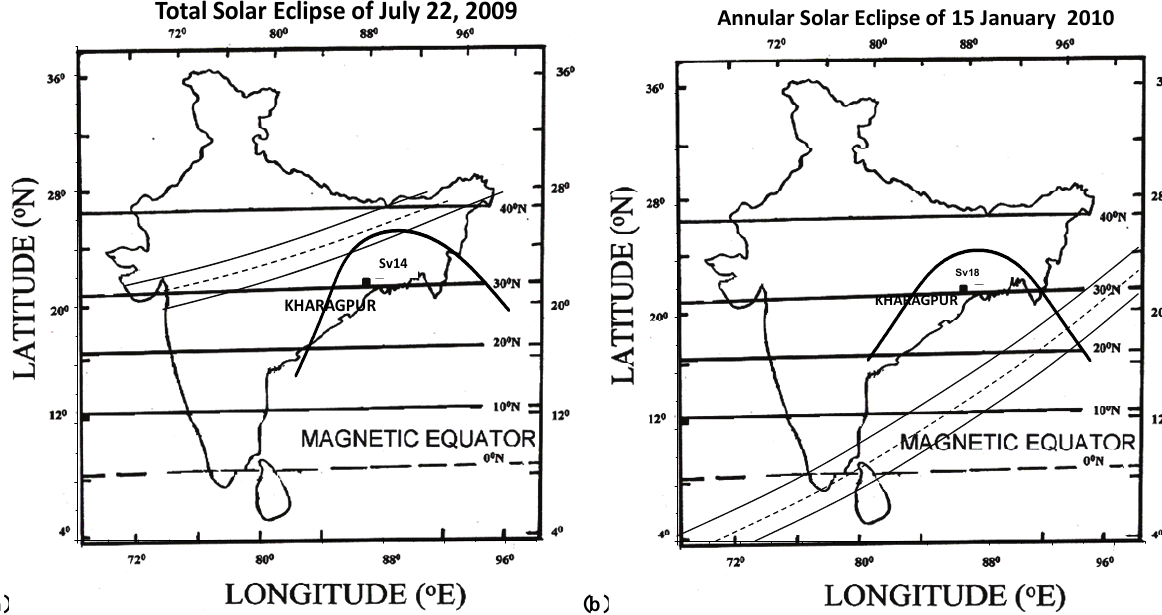
Fig. 1. Path of totality of the solar eclipse on 22 July 2009 over the Indian subcontinent and the track of SV14 observed from Kharagpur is shown in (a) and the path of the annular eclipse on 15 January 2010 with the track of SV18 observed from Kharagpur is shown in (b) . The location of the Kharagpur is also shown in the